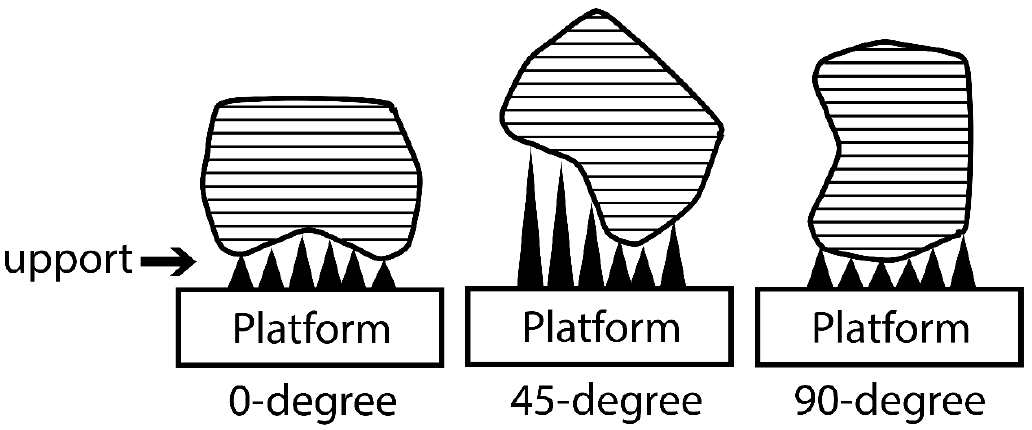
Figure 3. An illustrated diagram of the printed layers with di ff erent printing orientations for the 3D- printed IFDP specimens .